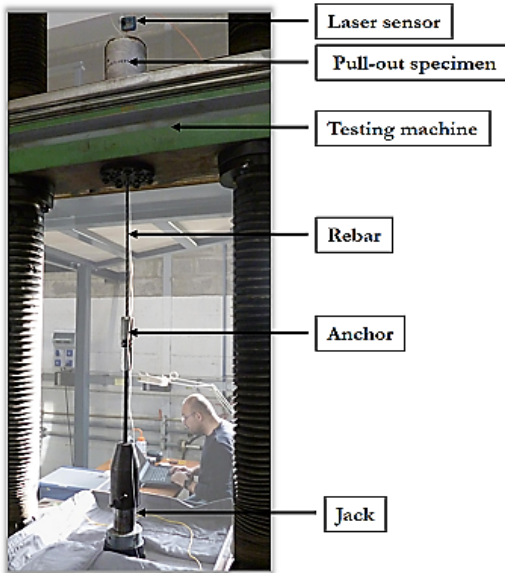
Figure 7. Picture of the pull-out test setup.